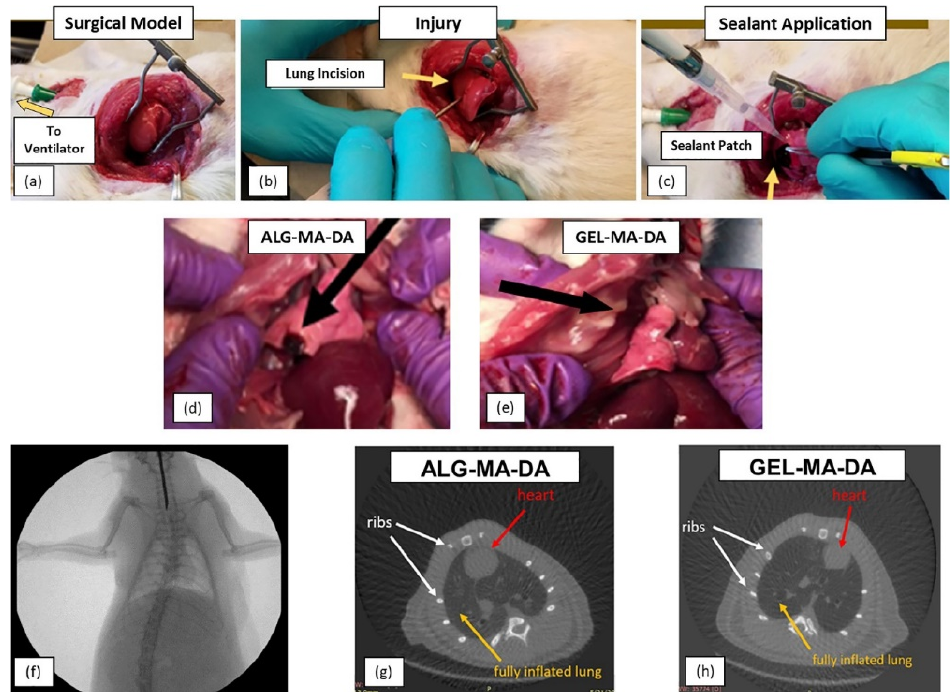
Figure 4. Representative images for in vivo model of rat tracheal injury. ( a,b , c ) Implementation of sealant patches on the site; ( d , e ) necropsy analysis one month post-operative. ( f ) fluoroscopy results of the lungs; ( g , h ) CT scans of the lungs after one month. (Reprinted with permission from Ref. [45]. Copyright 2021 Elsevier.).